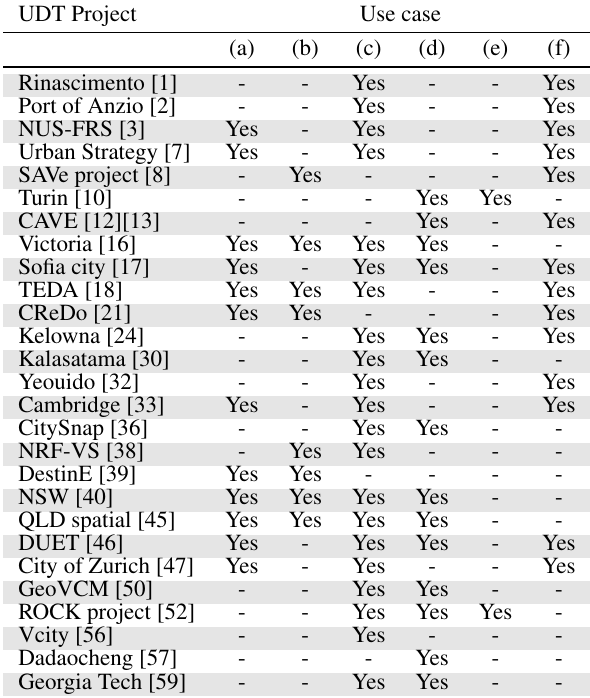
Table 1. Overview of the documented use cases for Urban Digital Twins classified into six groups: (a) District-/City-Level Forecasting (b) Emergency Planning (c) Operational Optimisation (d) Participatory Planning (e) Policy Development (f) Scenario Modelling. The use case columns are indicated